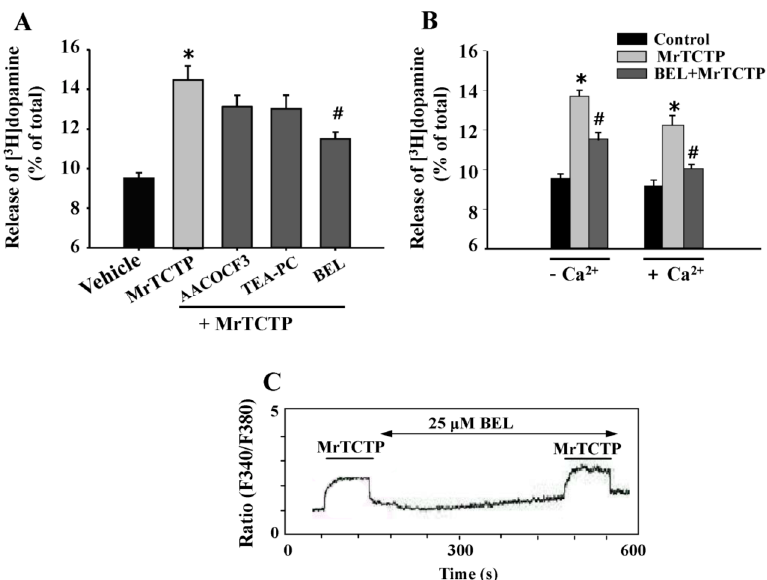
Figure 5. The effects of phospholipase A 2 (PLA 2 ) inhibitors on TCTP-induced dopamine release from PC12 cells. ( A , B ) PC12 cells were pre-incubated for 20 min at 37 °C with 25 µM AACOCF 3 , 10 µM TEA-PC, or 25 µM BEL, and then treated with 50 µg/mL MrTCTP for an additional 20 min in Ca 2+ -containing (+Ca 2+ ), or Ca 2+ -free ( − Ca 2+ ) buffer. The amount of [ 3 H]dopamine released into the culture supernatant was measured. * p < 0.05 relative to control release; # p < 0.05 relative to MrTCTP-treated release; ( C ) the fluorescence experiments were carried out at room temperature in the Ca 2+ (2 mM CaCl 2 )-containing buffer. PC12 cells were loaded with 5 µM Fura-2-AM for 30 min and then washed multiple times. The cells were pretreated with 25 µM BEL for 5 min, and then exposed